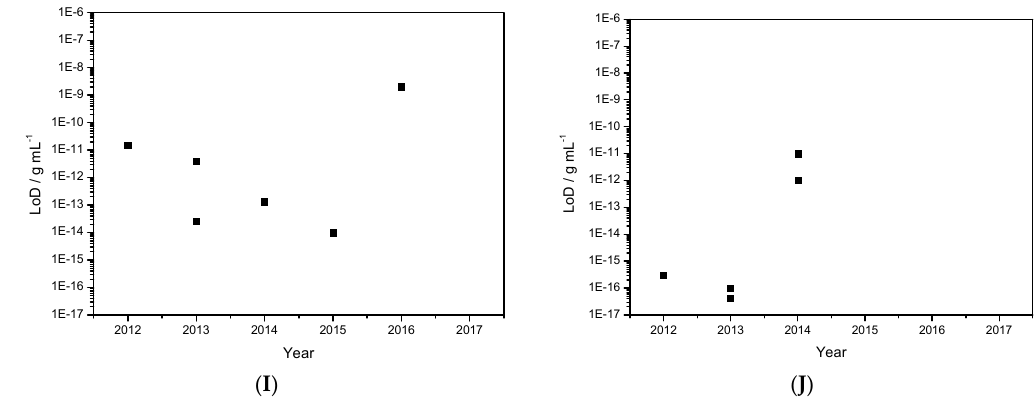
Figure 38. LoDs of electrochemical immunosensors, from 2012 to 2017, using ( A ) conventional electrode substrates (open squares, enzyme-based sensors; plain square, enzyme-free sensors); ( B ) carbon nanostructures (open squares, enzyme-based sensors; plain square, enzyme-free sensors); ( C ) enzyme-free immunosensors with graphene and diffusing redox probe; ( D ) enzyme-free immunosensors with graphene and immobilized redox probes; ( E ) enzymatic immunosensors using graphene; ( F ) enzymatic immunosensors with metal or metal oxide nanoparticles; ( G ) enzyme-free immunosensors with metal or metal oxide nanoparticles; ( H ) magnetic nanoparticles; ( I ) dendrimers; ( J ) ionic liquids.